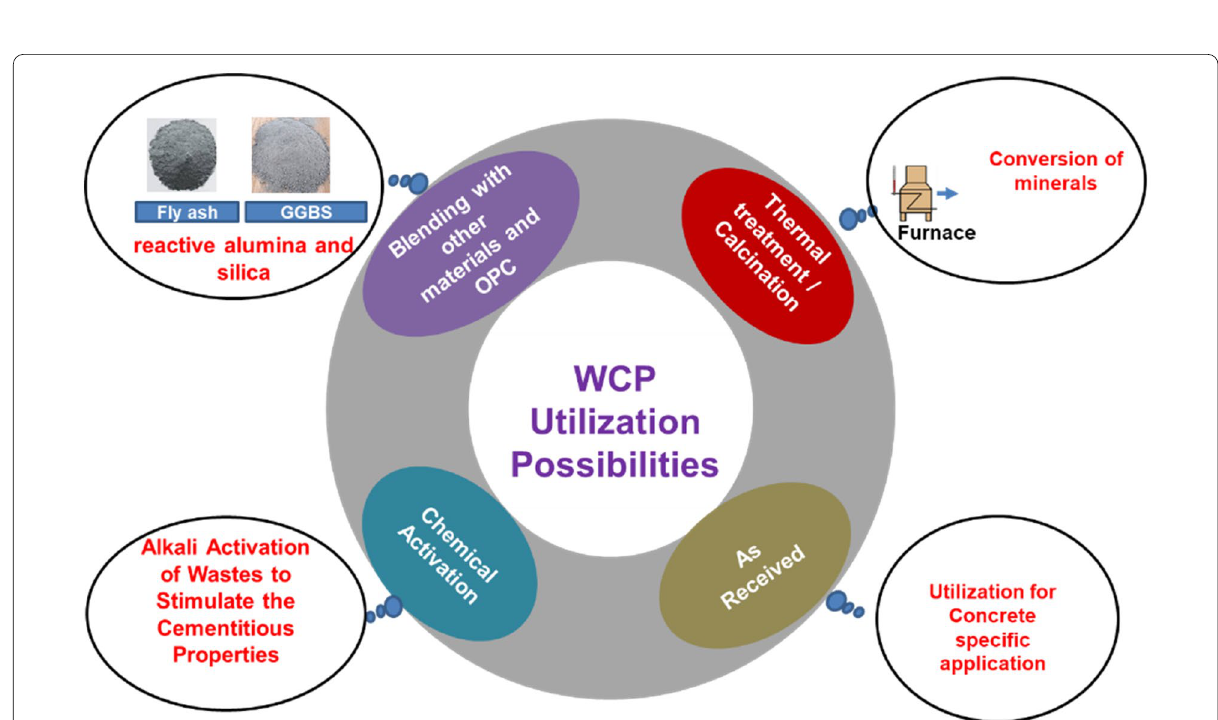
Fig. 3 WCP utilization